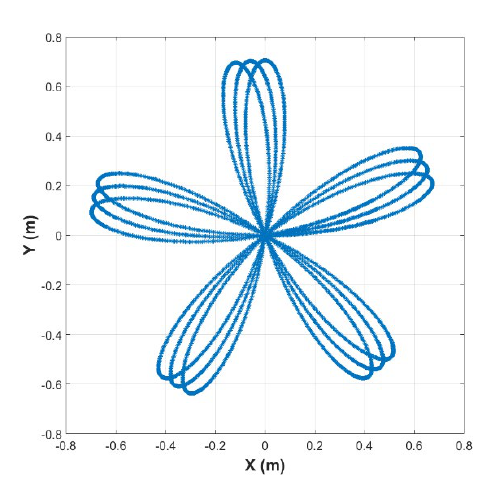
Figure 5. Three consecutive petal patterns. The last step for the LiDAR modelling is the angular error introduction, which is the angular difference between the theorical direction of each scanning ray and the real direction of that ray during the scanning process. This error usually has a normal distribution and the value given in the datasheet of the sensor is its 1 σ value. In order to introduce this error in the ray’s direction generated by the scanning pattern, two rotations around the perpendicular axis of the ray are carried out, using a normal distributed random number with the same distribution of the angular error of the LiDAR. Figure 6 shows the histogram of the angular error introduced to the rays defined by the scanning pattern.